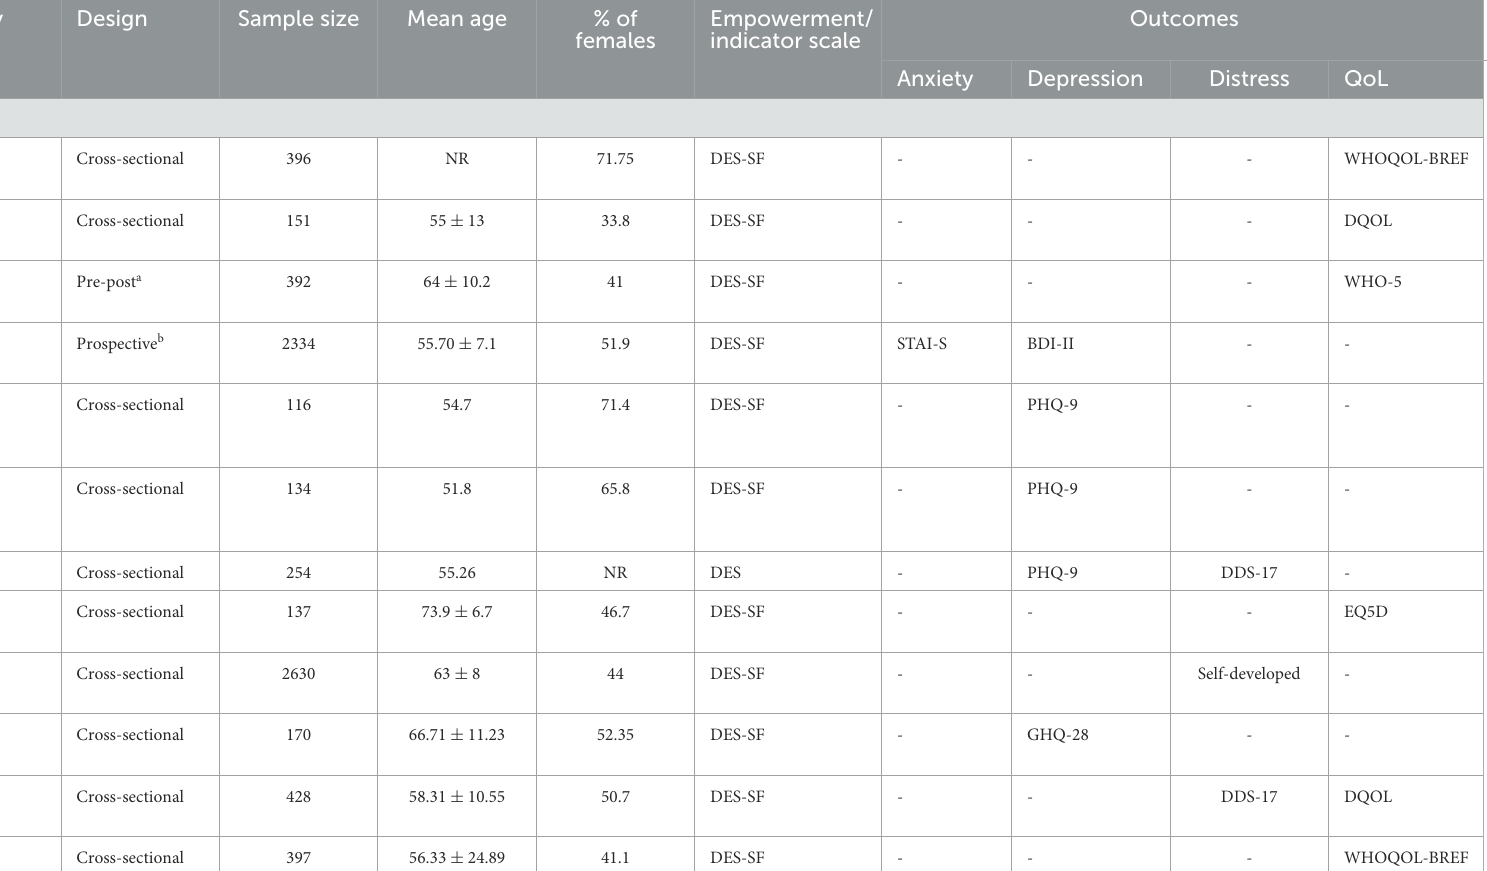
TABLE 1 Main characteristics of the included